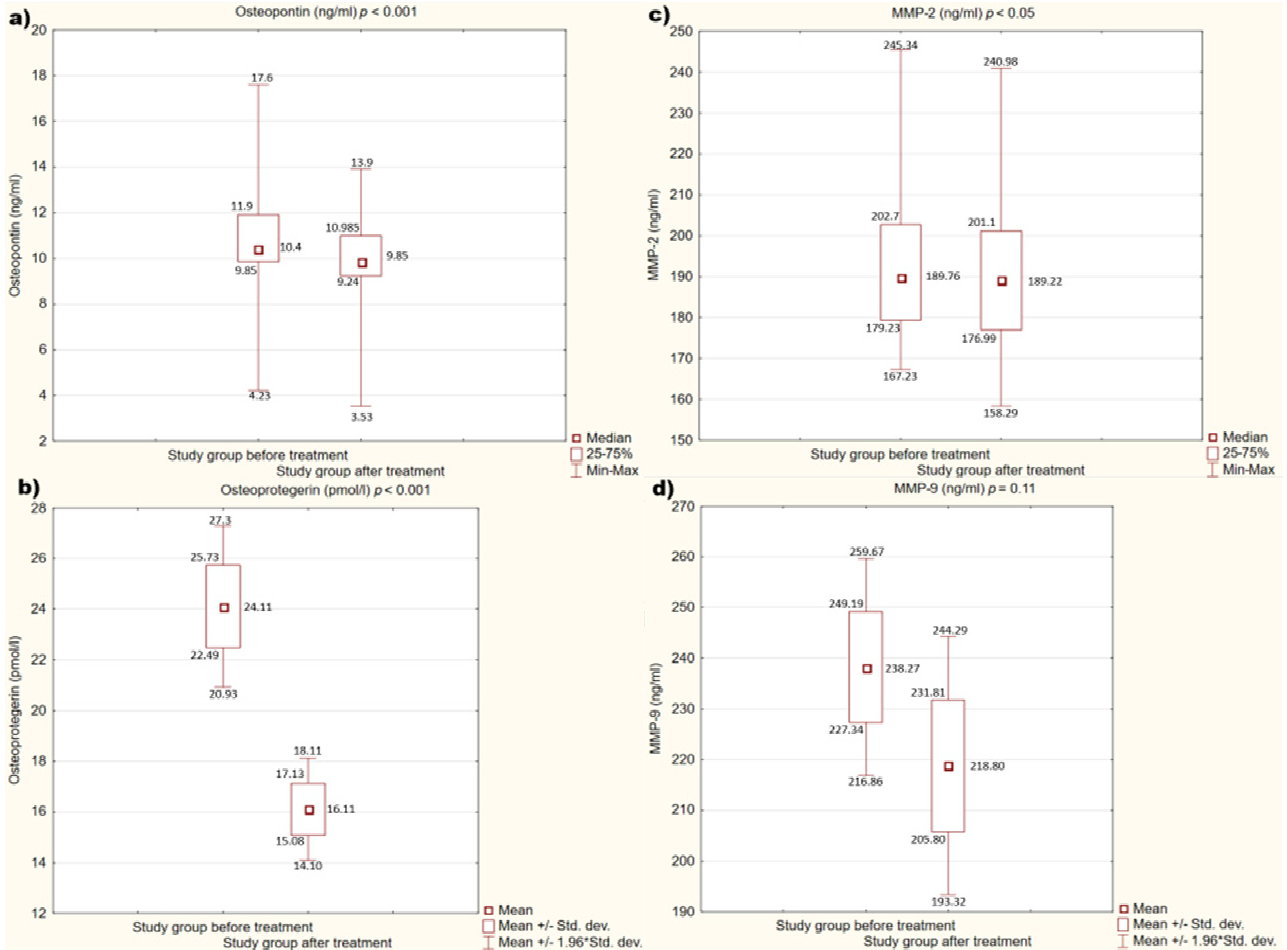
Figure 2. ( a – d ) . Concentration of studied factors in the study group before and after treatment. ( a ) Concentration of osteopontin (OPN) in the study group before and after treatment. ( b ) Concentration of osteoprotegerin (OPG) in the study group before and after treatment. ( c ) Concentration of metalloproteinase 2 (MMP-2) in the study group before and after treatment. ( d ) Concentration of metalloproteinase 9 (MMP-9) in the study group before and after treatment.